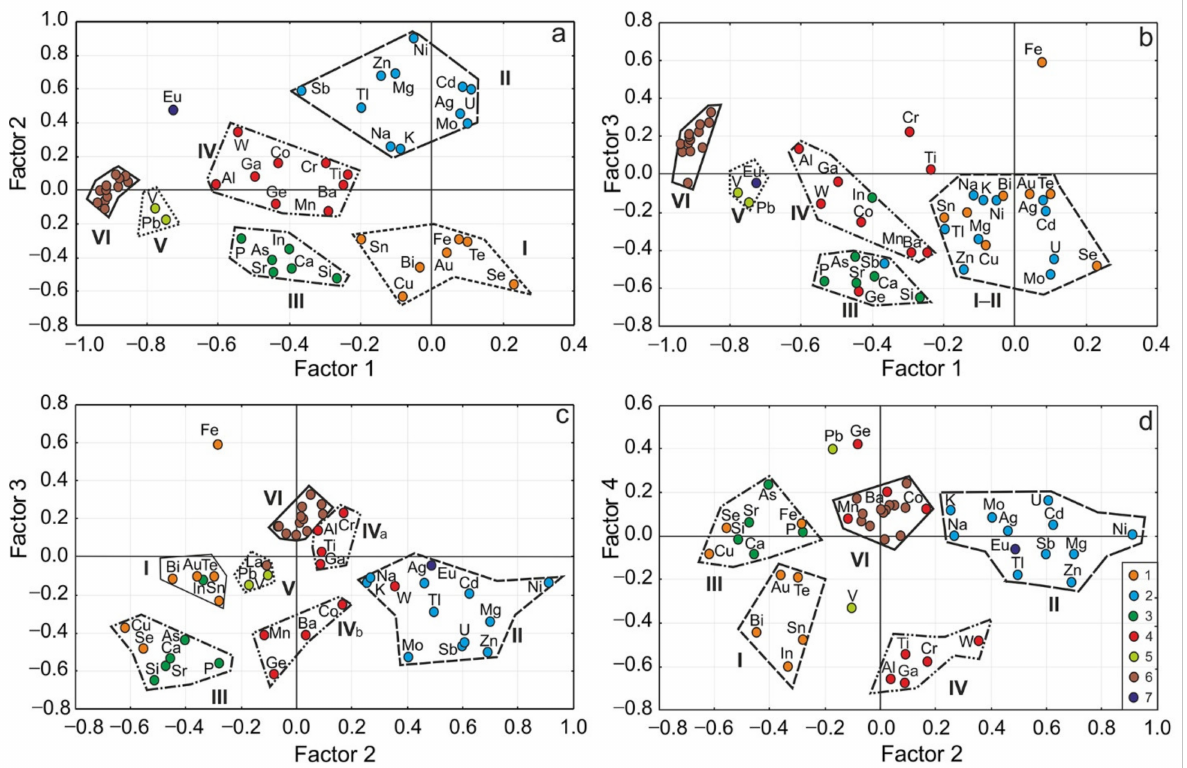
Figure 4. Trace element assemblages calculated for the IOHs of the Pobeda-1 hydrothermal field by R-mode factor correlations: ( a , b ) Factor 1 vs. Factor 2 and 3; ( c , d ) Factor 2 vs. 3 and 4. Rotation: Unrotated. Extraction: Principal components. TEs of: 1—Cu–Fe sulfides; 2—Zn sulfides